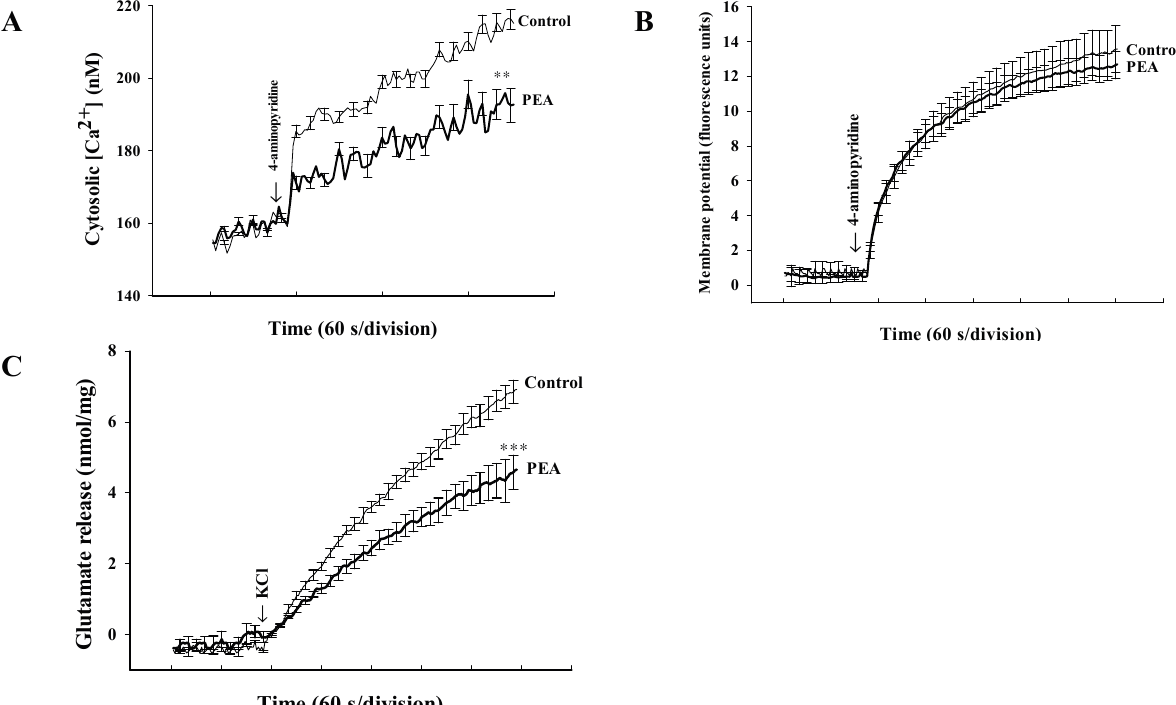
Figure 3. PEA reduces the 4-aminopyridine-induced increase in cytosolic Ca 2+ concentration ([Ca 2+ ] C ) but fails to alter the synaptosomal membrane potential. The [Ca 2+ ] C (nM) ( A ) or synaptosomal membrane potential ( B ) was measured in the absence (control) and in the presence of 5 μ M PEA, added 10 min before depolarization with 1 mM 4-aminopyridine. ( C ) Inhibition of KCl (15 mM)-evoked glutamate release by PEA. Results are mean ± SEM of 5 independent experiments. ** p < 0.01, *** p < 0.001 versus control